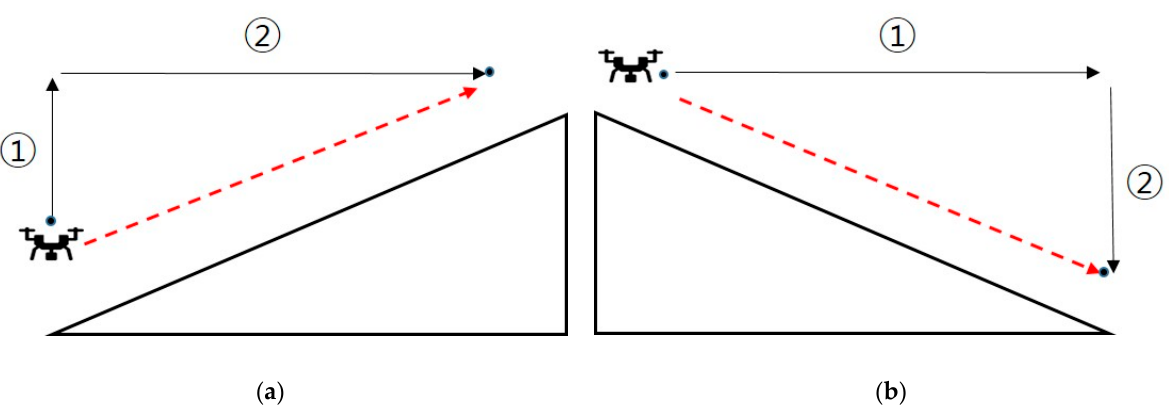
Figure 8. Example of UAV operation in terrain with a change in elevation. ( a ) When the elevation increases, raise the UAV vertically at the point where the change starts and then proceed again. ( b ) When the elevation decreases, descend vertically from the point where the elevation is lowered and then designate a waypoint. The black dots are where the waypoints will be saved. Dotted lines are the flying routes between the waypoints when the automatic flight is performed.